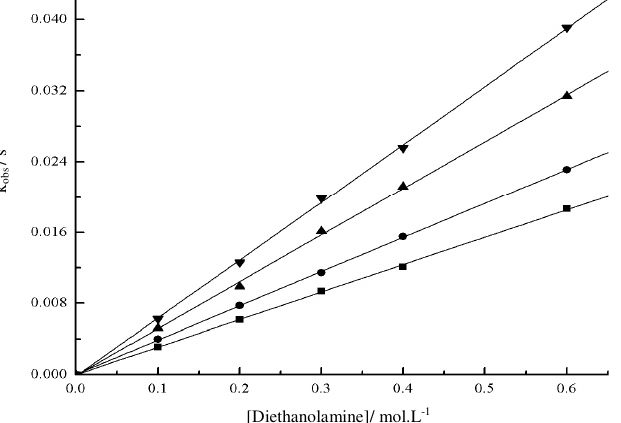
Figure 1. Plots of k versus [Diethanolamine] at different temperatures(r ≥ 0.999), [Fe(VI)] obs